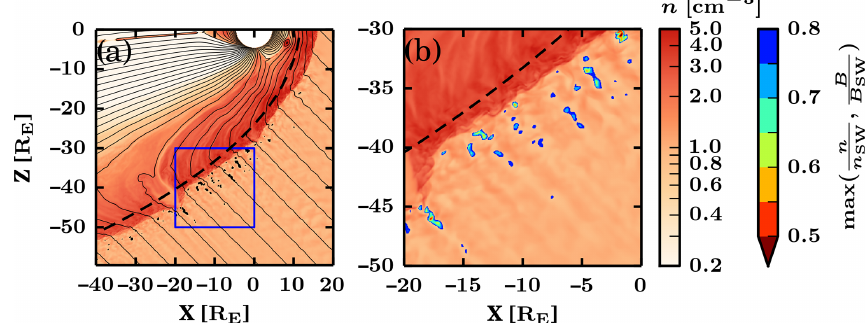
Figure 1. Two zoomed-in views of the studied Vlasiator simulation run showing the foreshock at t = 1012 . 5s. The background colour displays the proton number density n (left colour bar), and the thin black continuous lines represent the magnetic field B . Panel (a) shows cavitons and SHFAs marked in black. The area delimited by the blue square is shown in panel (b) , where the transient depth (defined as the maximum between n and the magnetic field magnitude B normalised by their solar wind values) is shown (right colour bar). The thick dashed line represents the boundary behind which cells fulfilling the caviton criteria are ignored.